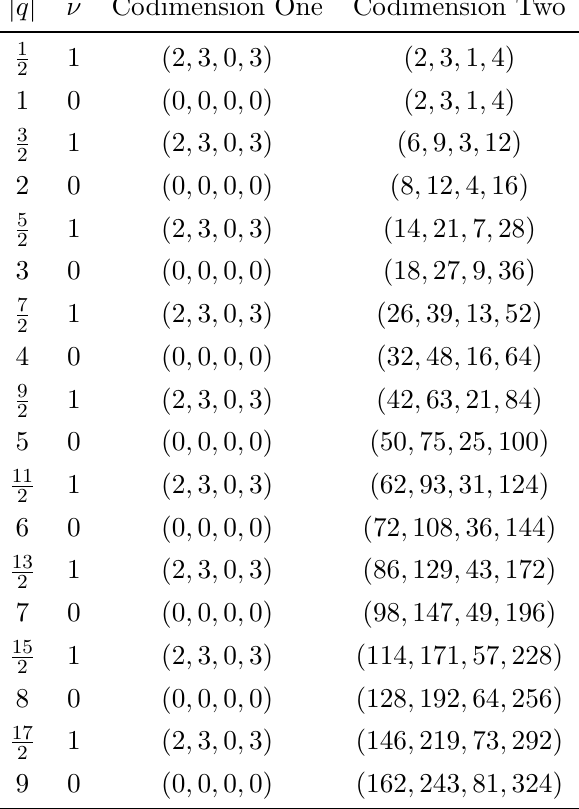
Table 21. Orders of vanishing of (ˆ x, ˆ y, ˆ z, ˆ w ) for combinations of ν and the 56 pseudo-charge q at codimension one ( { σ = 0 } ) and codimension two ( { σ = b = 0 } ). These data are found by calculating multiples of the generating section (10.8) for the e (1) Weierstrass model in eq. (10.7); 7 ⊕ u pseudo-charge q is realized by the section 2 q ˆ s . One should observe the same orders of vanishing in Weierstrass models supporting 56 q ⊕ 1 2 q